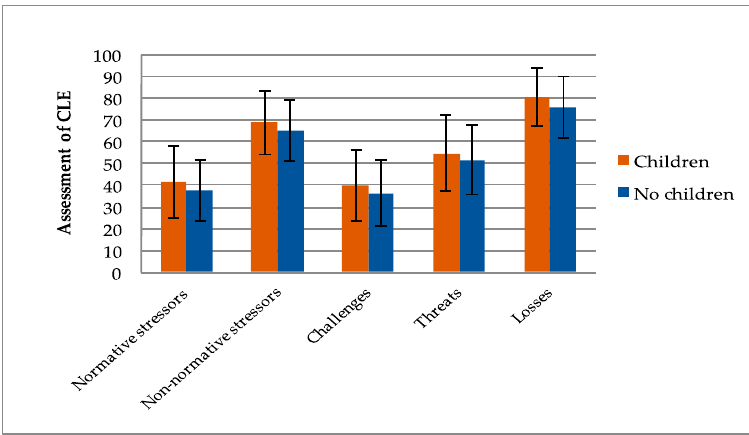
Figure 2. Mean differences between participants with children and participants without children regarding the assessment of normative stressors, non-normative stressors, challenges, threats and losses. Error bars represent standard deviation.